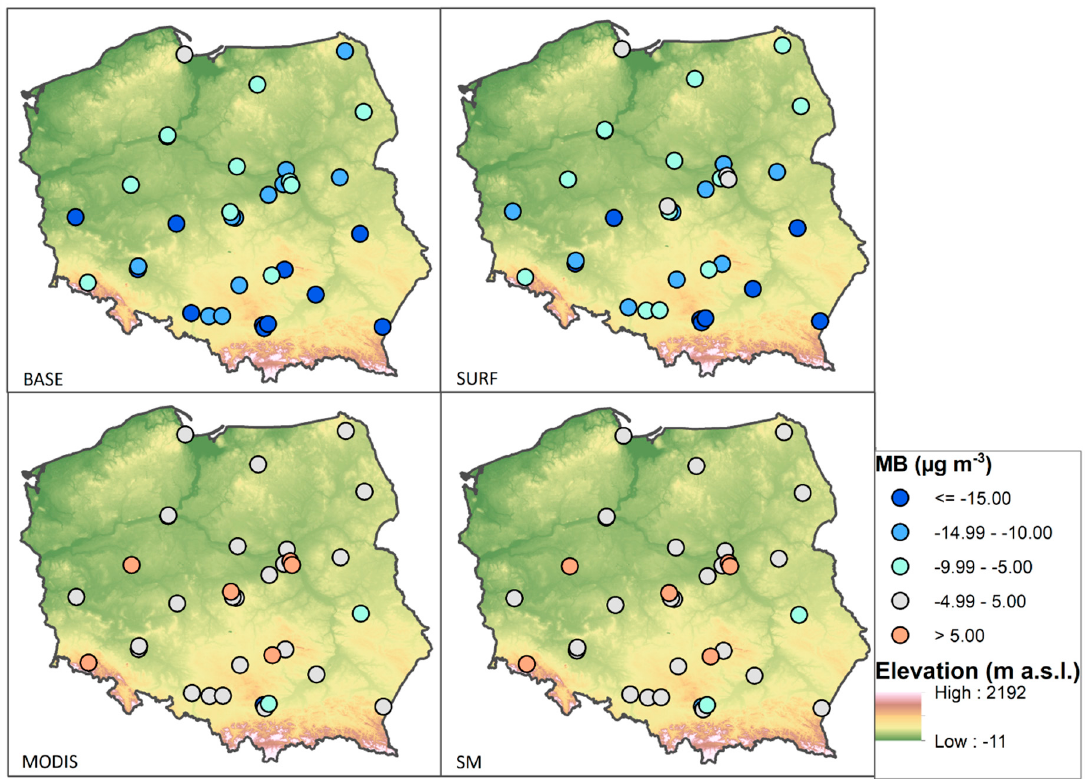
Figure 6. Spatial distributions of MB for PM2.5 concentrations for the summer 2015 episode. Elevation in meters above sea level (m a.s.l.)